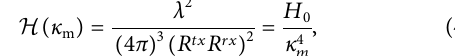
FIGURE1|(A) Illustrationofthejointradar-communication(JRC)scenario.Thebasestation(BS)at ( L that supports both radar and comm. functionalities with a directional and recon fi gurable antenna system of Δ θ tx beamwidth. An omnidirectional receiver (RX) at (− L forms the passive/bistatic radar receiver. The channel consists of mobile users (MU) at ( r m , θ m ) at distances, R tx m and R rx m , from BS and MU respectively indicated by blue dots; and undesirable clutter scatterers indicated by red dots. The bistatic radar angle is β . (B) Timing diagram of the JRC framework where each T consists of T search = ϵ T whentheBSscanstheangularsearchspaceforMUusing n beam of T beam duration.Duringtheremaining T serve duration,directionalbeamlinksareestablished between BS and MU based on the localization by the radar during T search